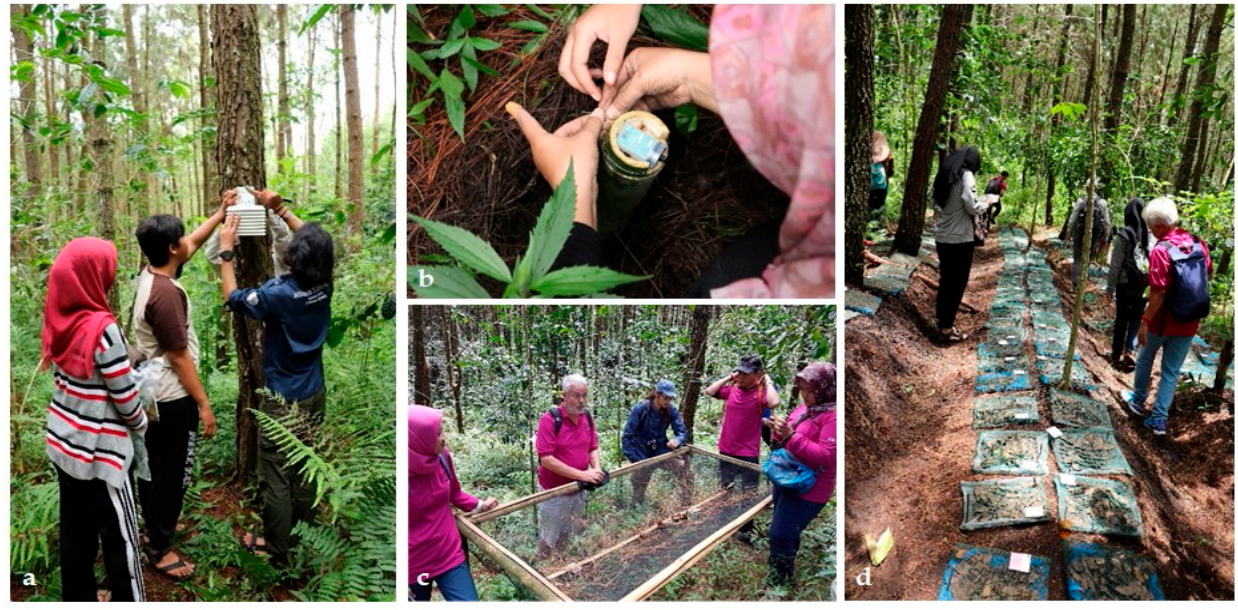
Figure 4. Examples of measurements being conducted within UB Forest. ( a ) Solar shield containing a combined temperature and humidity sensor/logger being attached to a pine tree trunk. ( b ) Ground level light sensor being deployed. ( c ) Litter trap, utilised in measuring and modelling of carbon cycling in the forest. ( d ) Litter bag experiment being deployed to explore decomposition rates.